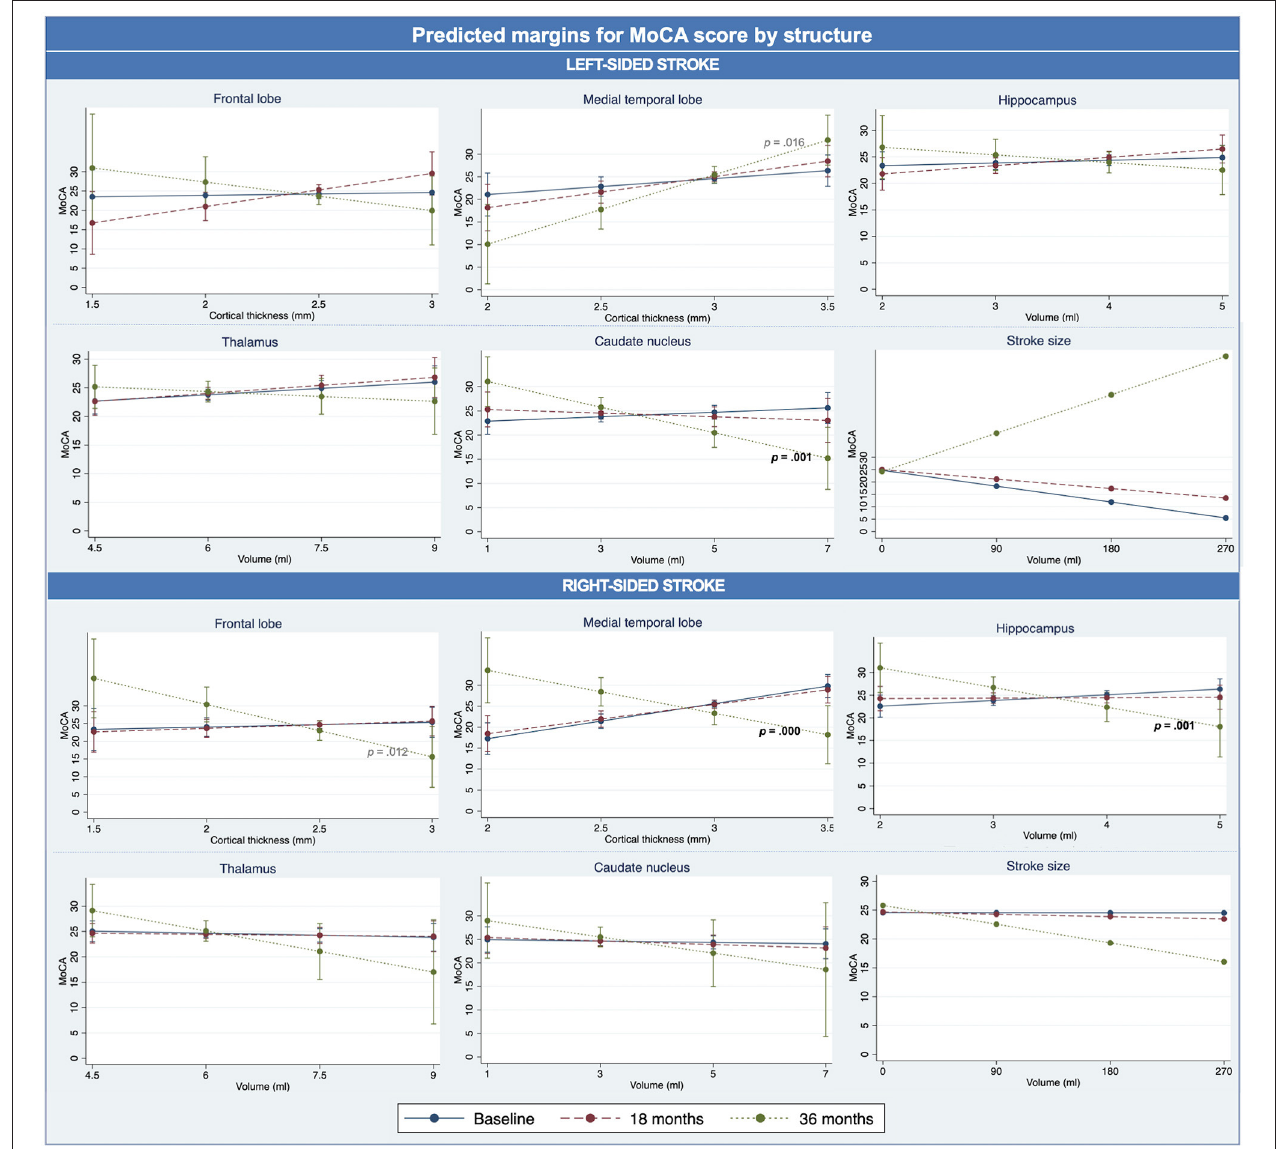
FIGURE 3 | Brain changes and cognition – analysis II. Estimated marginal means for MoCA score for each structure, over time. Significant p- values in black bold, near significant p- value in gray